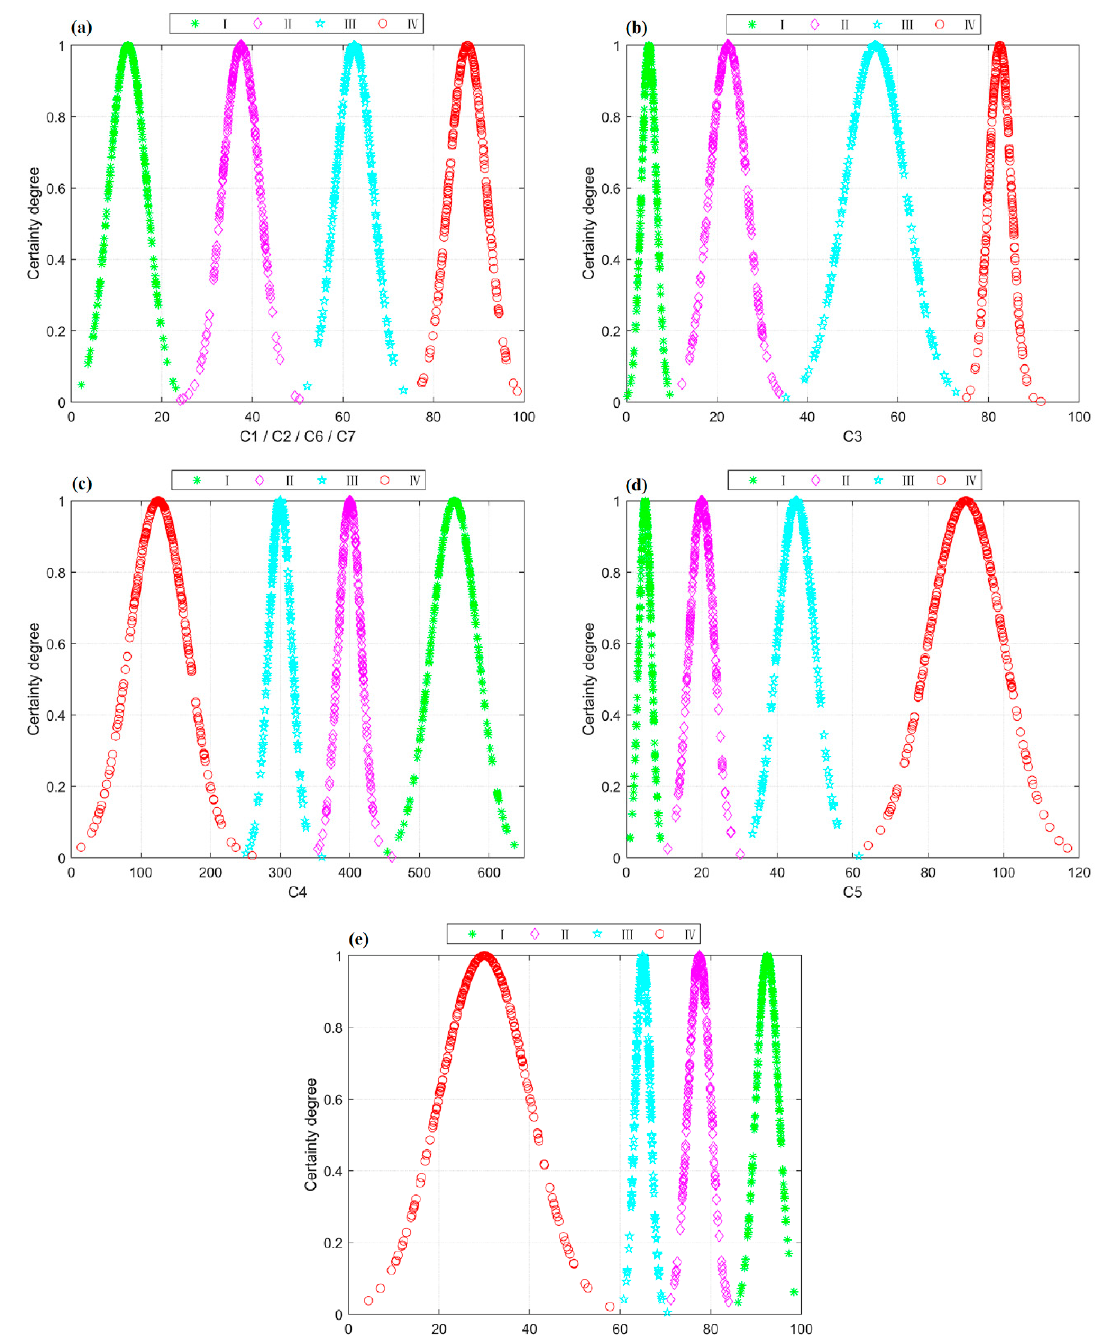
Figure 7. Cloud of each assessment index generated by the forward cloud generator. ( a ) landform and physiognomy (C 1 ), unfavorable geological conditions (C 2 ), water supply (C 6 ), and excavation disturbance (C 7 ); ( b ) strata inclination (C 3 ); ( c ) strength of the surrounding rock (C 4 ); ( d ) groundwater level (C 5 ); ( e ) supporting measures (C 8 ), monitoring measurement (C 9 ), and geological prediction (C 10 ).